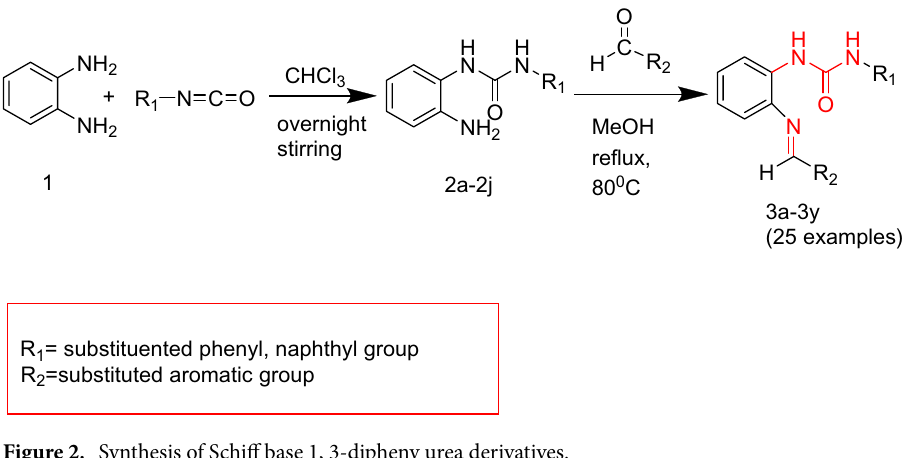
Figure 2. Synthesis of Schiff base 1, 3-dipheny urea